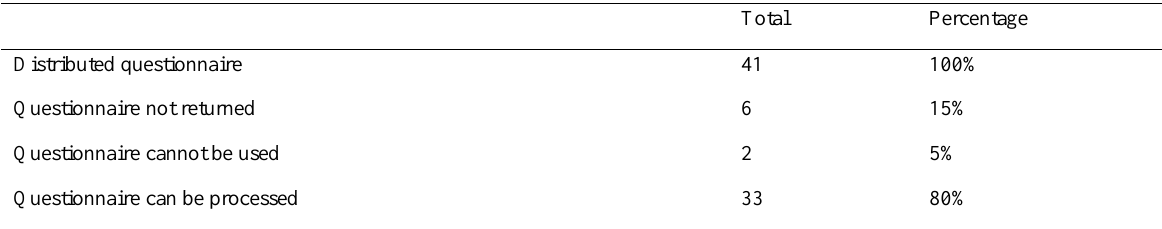
Table 2: Questionnaire Return